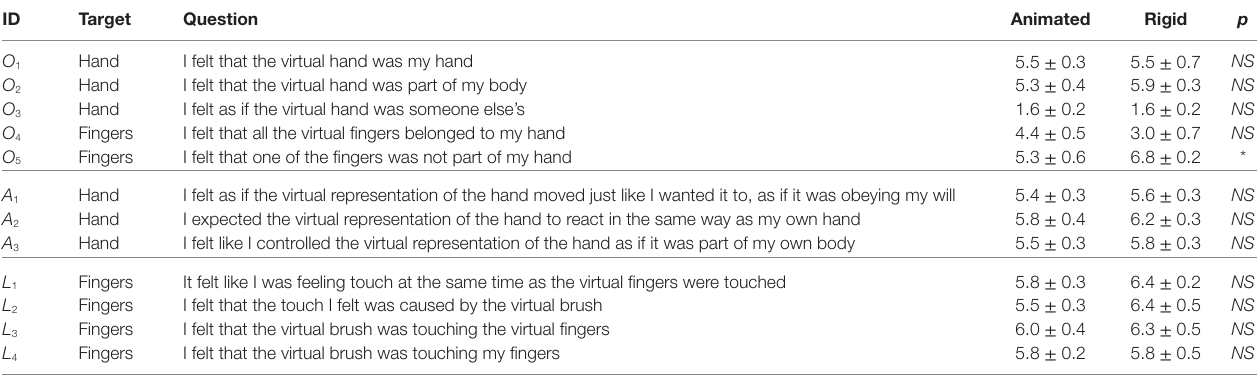
Animated Rigid animated